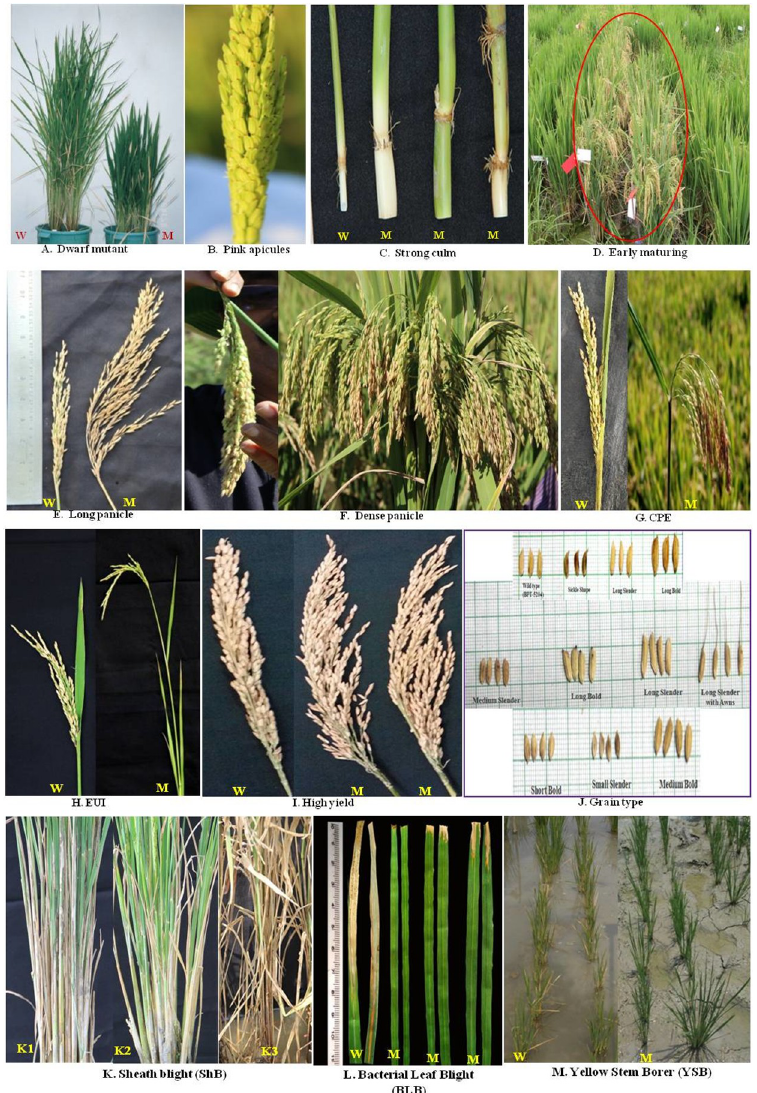
Fig 2. A—M: Variants for different traits in the mutagenized population of Samba Mahsuri; W- Wild type Samba Mahsuri; M- Mutant; K1- Wild type with score 9; K2- Resistant mutant (SB 6) with score 1 and K3- Susceptible check TN 1 with score